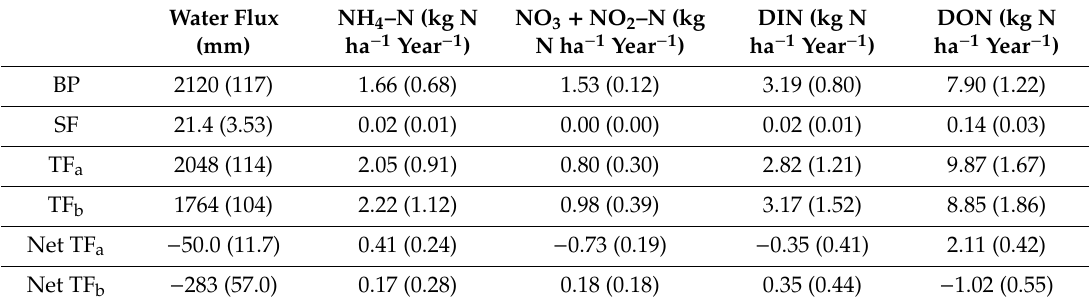
Table 3. Water flux (mm), dissolved nitrogen fluxes (kg N ha − 1 year − 1 ) in bulk precipitation (BP),